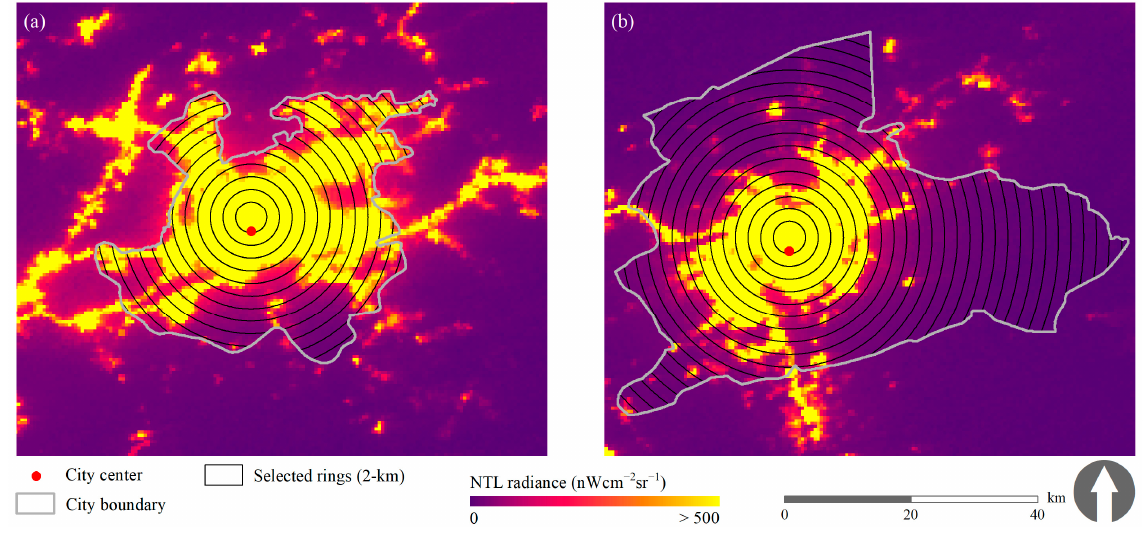
Figure 4. Concentric rings (2 km) in ( a ) Makkah and ( b )